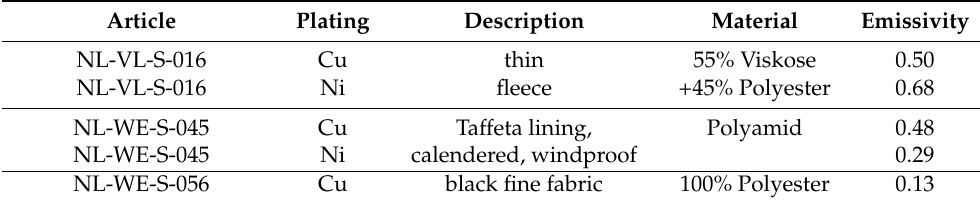
Table 1. Selected results of textile